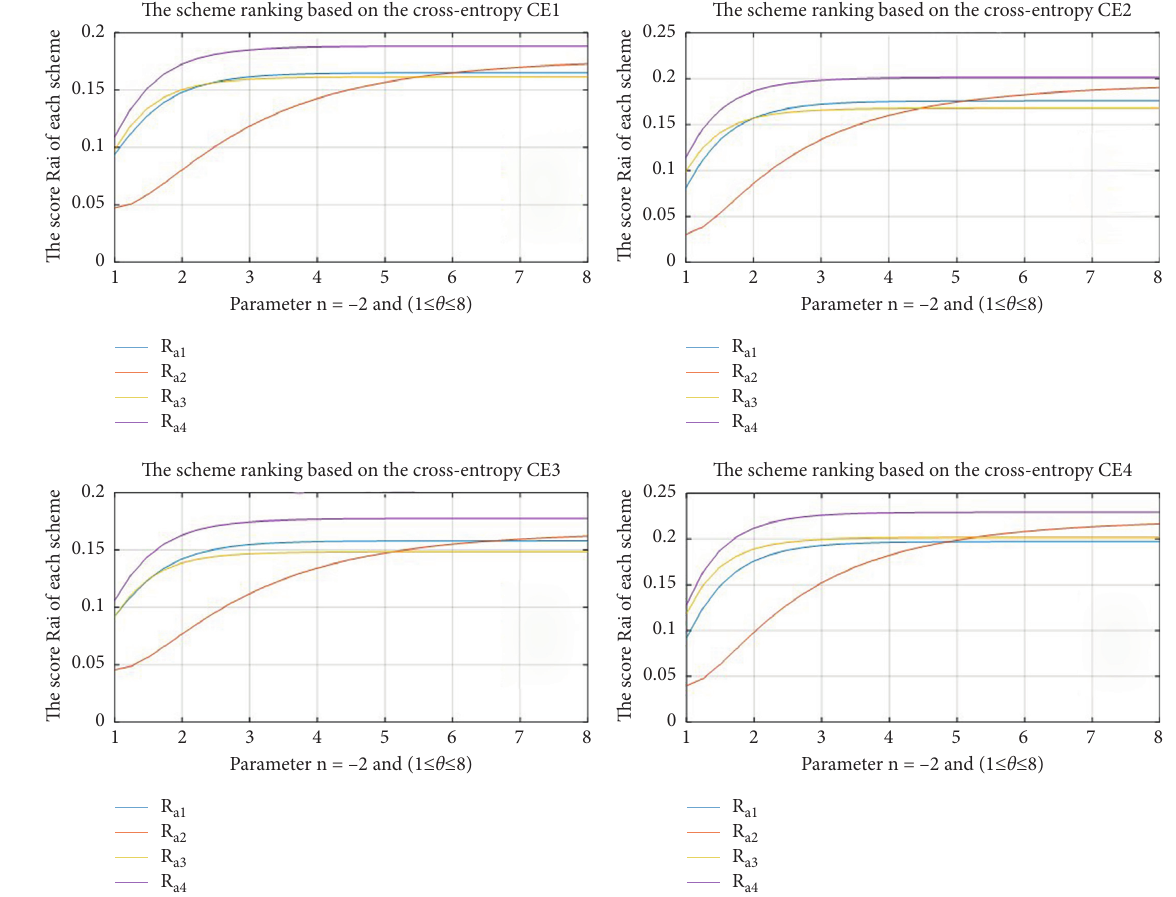
Figure 10: Ranking score of each alternative based on parameters n � − 2, 1 ≤ θ ≤